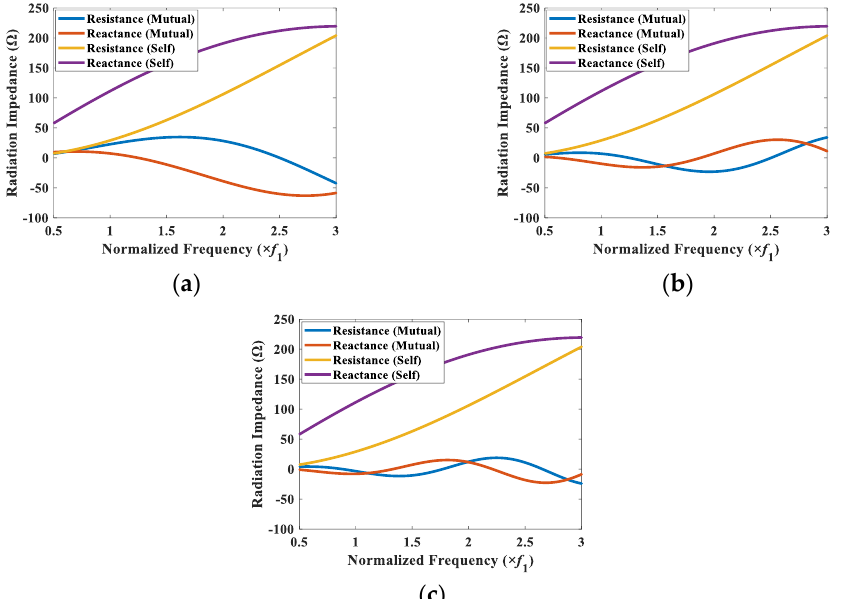
Figure 10. Self − and mutual radiation impedance of element 1 with its neighboring elements (CTC spacing of 0.2 𝜆 ): ( a ) elements 1 and 2; ( b ) elements 1 and 7; ( c ) elements 1 and 9.